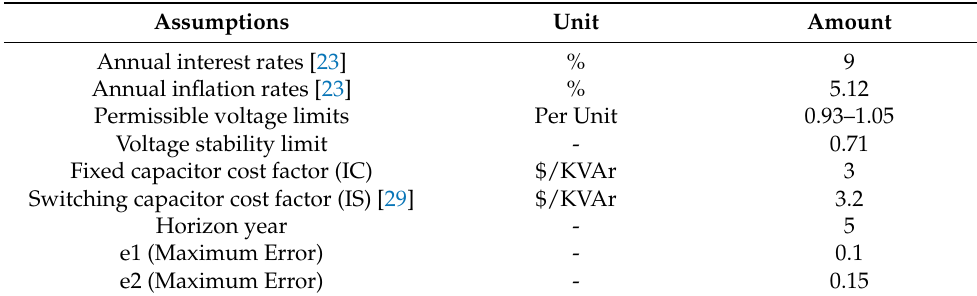
Table 4. The status of each response in terms of objective